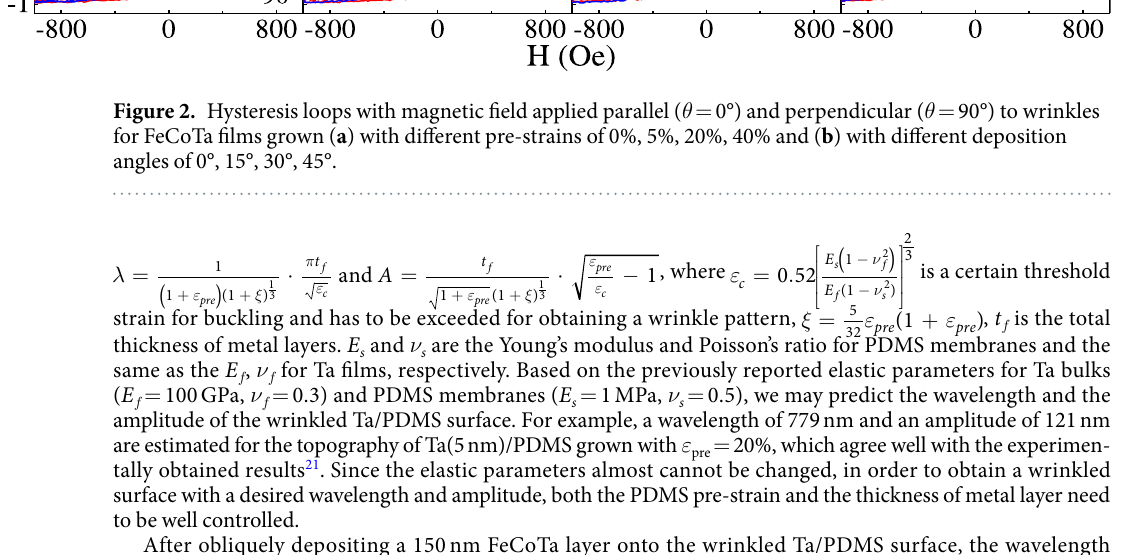
Figure 2. Hysteresis loops with magnetic field applied parallel ( θ = 0°) and perpendicular ( θ = 90°) to wrinkles for FeCoTa films grown ( a ) with different pre-strains of 0%, 5%, 20%, 40% and ( b ) with different deposition angles of 0°, 15°, 30°,